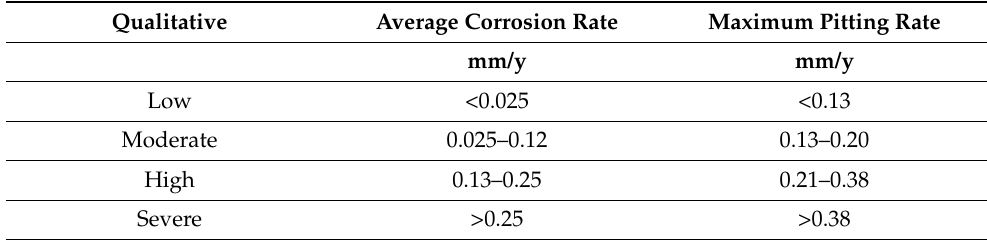
Table 3. Qualitative Categorization of Carbon Steel Corrosion Rates for Oil Production